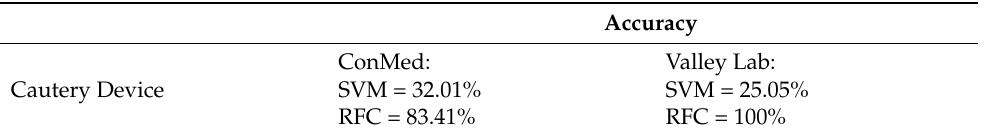
Table 6. Average accuracy detecting the energy level for each cautery using the first five princi- pal components.